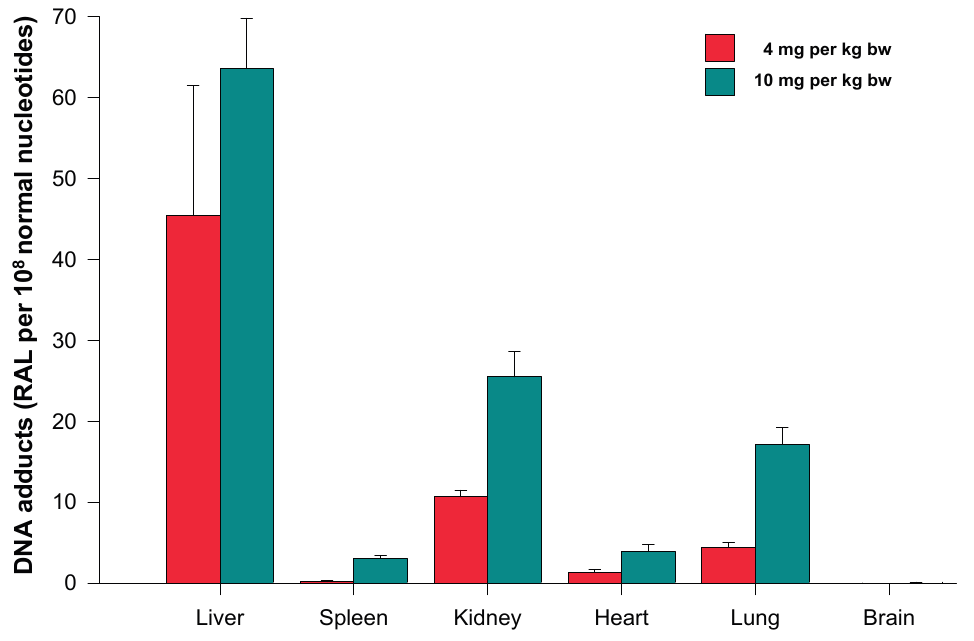
Figure 4. Ellipticine-derived DNA adducts (total levels of DNA adducts) formed in rats treated with free ellipticine (4 and 10 mg per kg body weight (bw)). Data shown are means ± S.D. from three rats. RAL, relative adduct